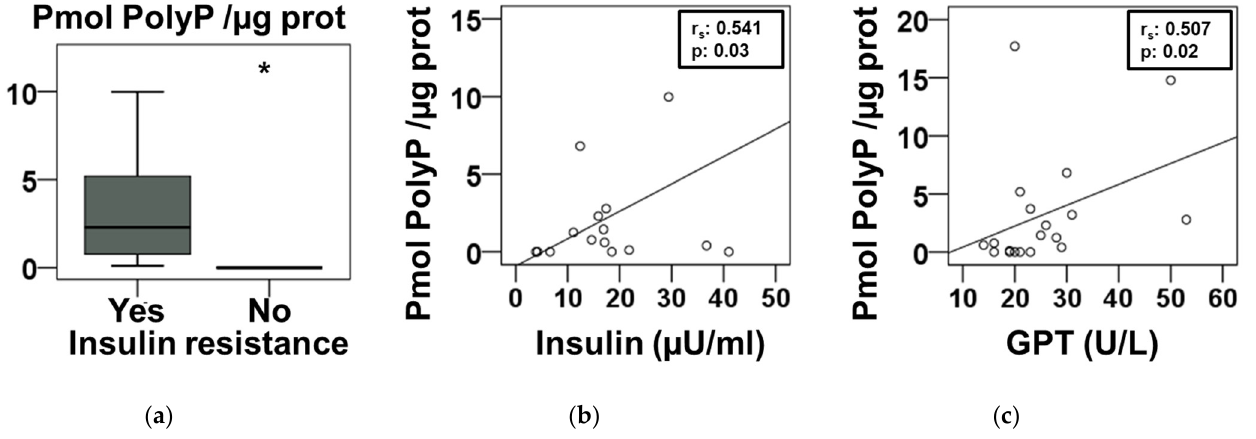
Figure 2. Insulin resistance in children is associated with increased blood plasma polyphosphate levels. ( a ) Plasma polyphosphate (polyP) levels, presented in Figure 1a, were reanalyzed with respect to the diagnosis of insulin resistance (IR) using HOMA-IR indexes ( n = 16 with IR and n = 9 without IR). Results are presented in a box-and whiskers plot and the asterisks indicates a statistical difference of p -value < 0.05, determined by Mann–Whitney test. ( b , c ) Graphic representation and Spearman’s correlation analysis of plasma polyP and plasma insulin ( b ), and plasma alanine transaminase activity (GPT) ( c ). “r s ”: Spearman’s correlation coefficient.